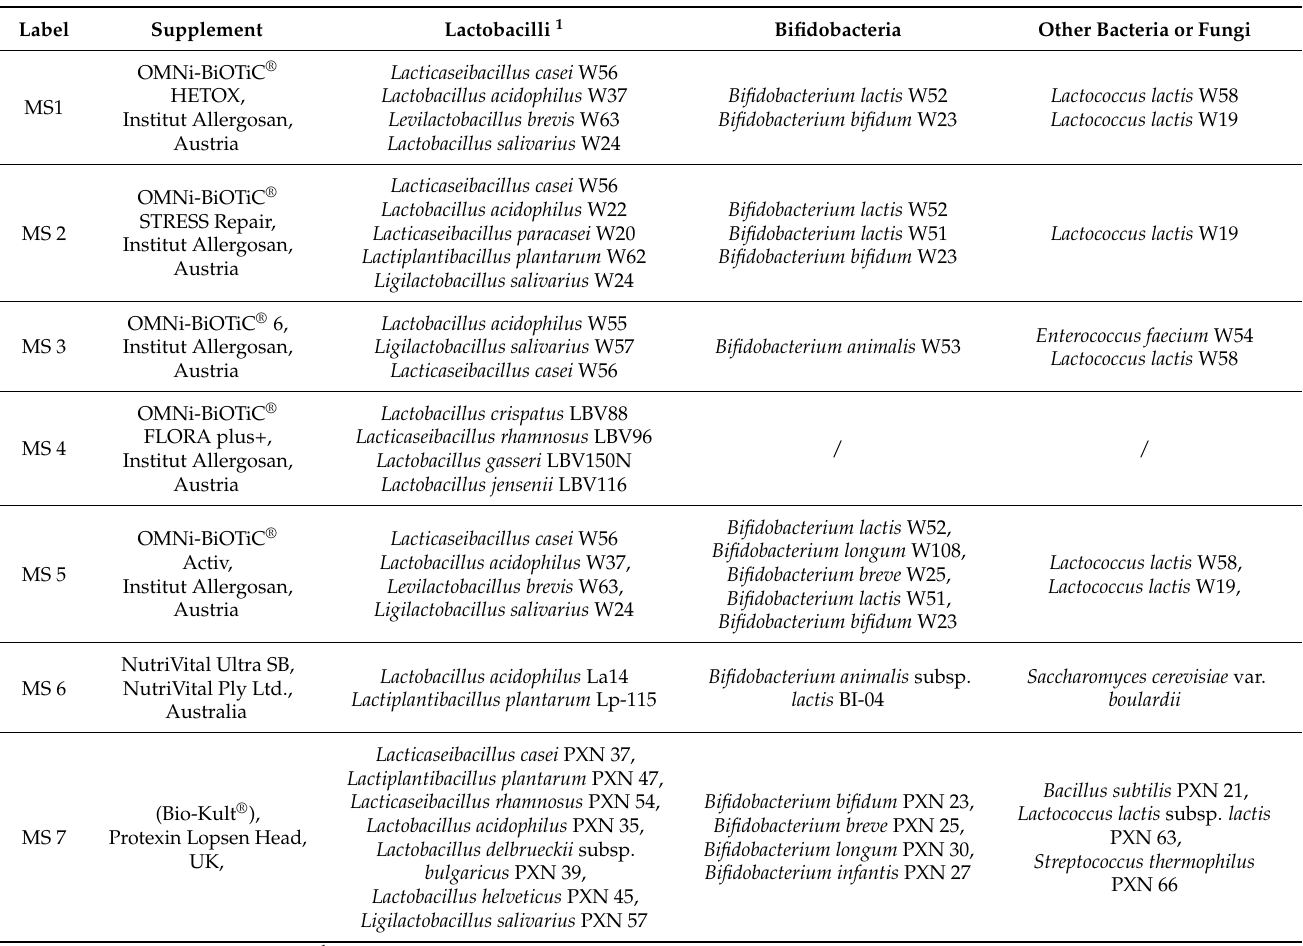
Table 1. Multi-strain dietary supplements containing various probiotic strains.